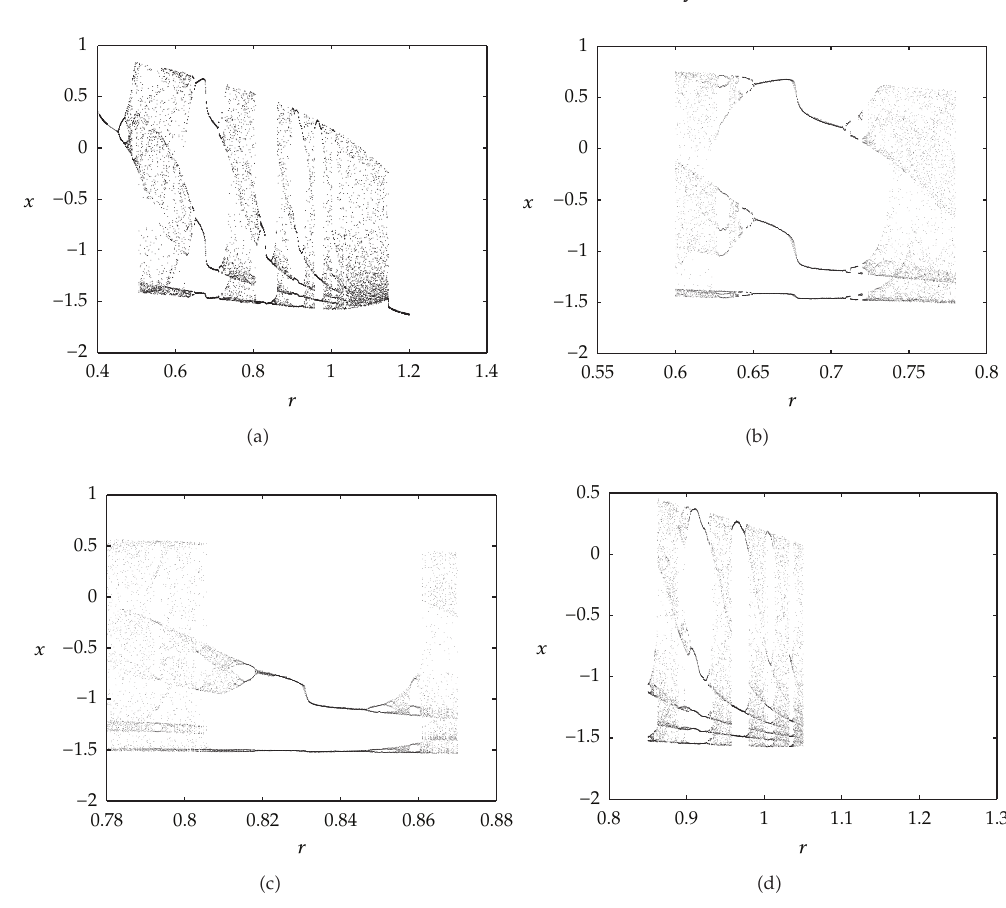
Figure 6: (cid:6) a (cid:7) Bifurcation diagram of the system (cid:6) 1.6 (cid:7) in (cid:6) r,x (cid:7) plane for F (cid:8) 1, D (cid:8) 1, δ (cid:8) 0 . 5, δ 1 (cid:8) 0 . 05, δ 2 (cid:8) 0 . 1, δ 3 (cid:8) 0 . 2, ω (cid:8) 1, r 1 (cid:8) 0 . 01, and r 2 (cid:8) 0 . 001. (cid:6) b, c, and d (cid:7) Amplified bifurcation diagram of Figure 6 (cid:6) a (cid:7) : (cid:6) b (cid:7) 0 . 55 (cid:2) r (cid:2) 0 . 80; (cid:6) c (cid:7) 0 . 78 (cid:2) r (cid:2) 0 . 88; (cid:6) d (cid:7) 0 . 80 (cid:2) r (cid:2) 1 .